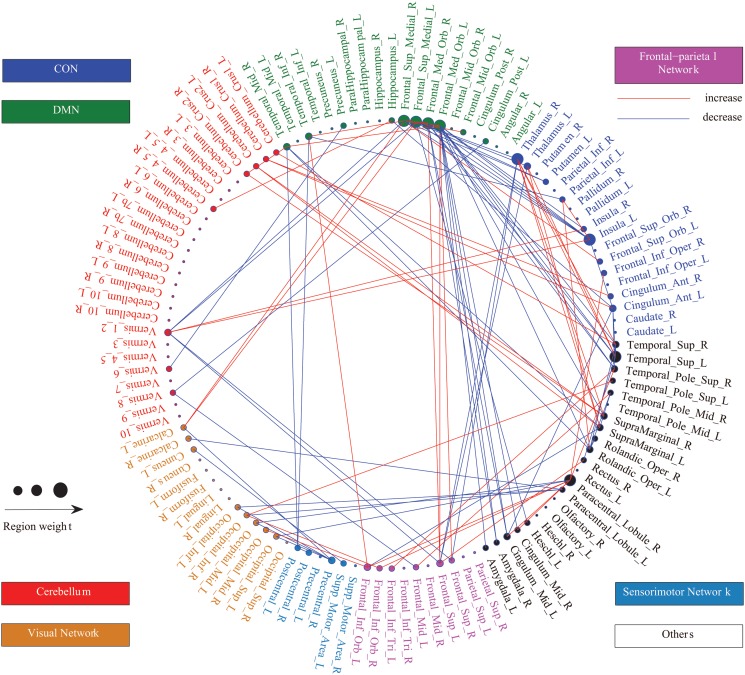
Region weights and the distribution of the 105 consensus functional connections.Regions are color-coded by category (CON, blue; DMN, green; cerebellum, red; visual network, brown; sensorimotor network, cyan; frontal-parietal network, rose; and others, black) and size-coded by weight. The line colors representing the change directions of the consensus functional connections in the patients are red for increases and blue for decreases.